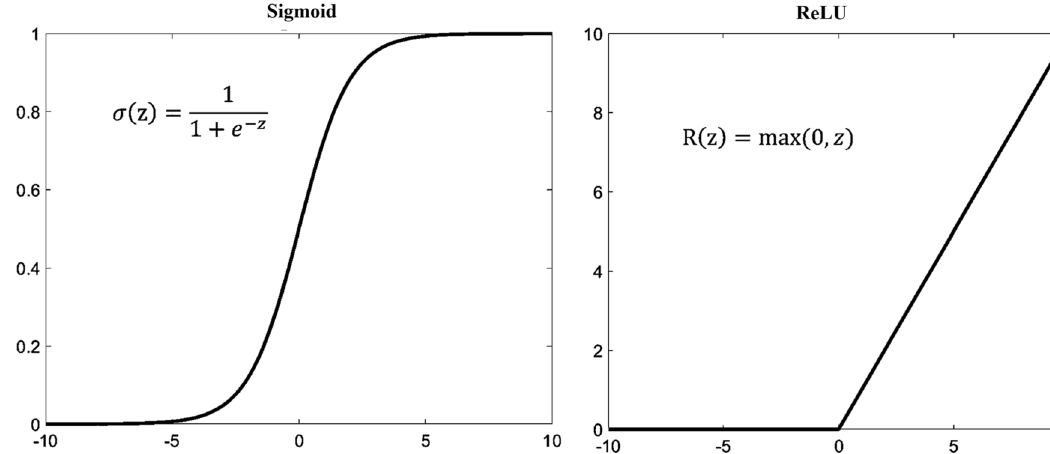
Fig. 5 Sigmoid activation function and ReLU activation function